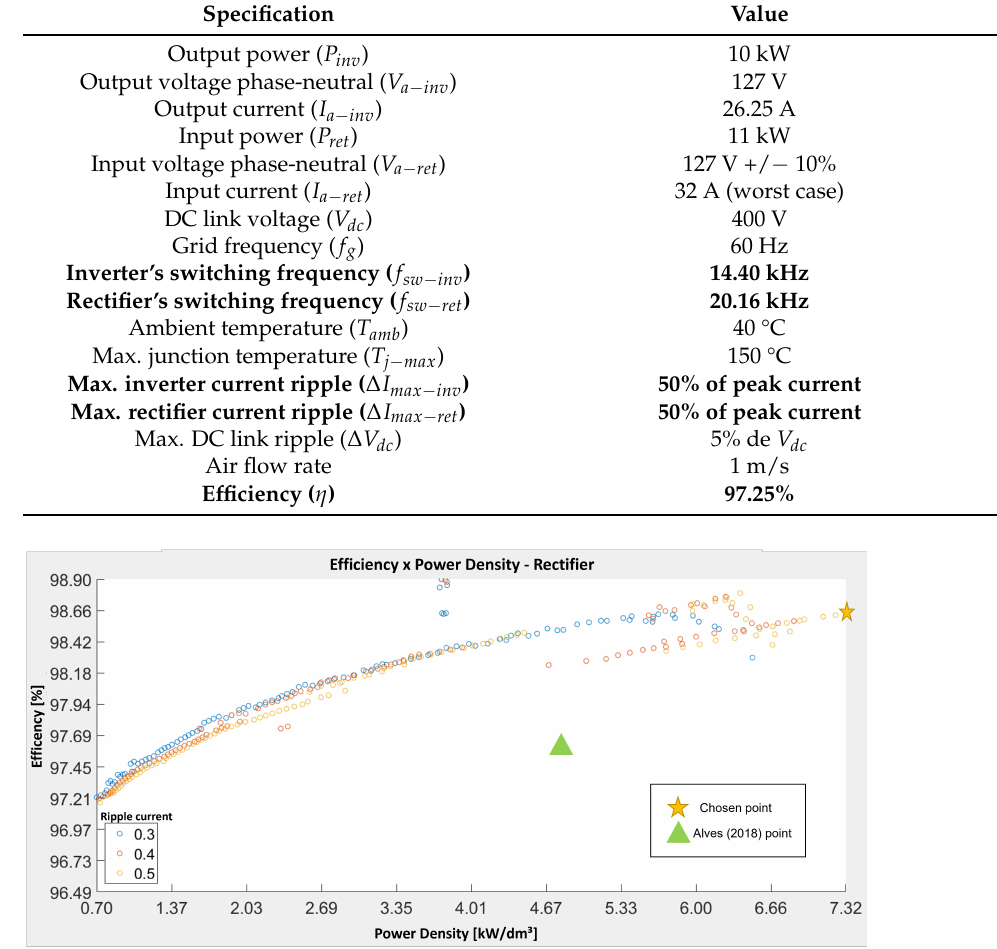
Table 3. Requirements and design criteria for the UPS using the proposed mCAD tool.